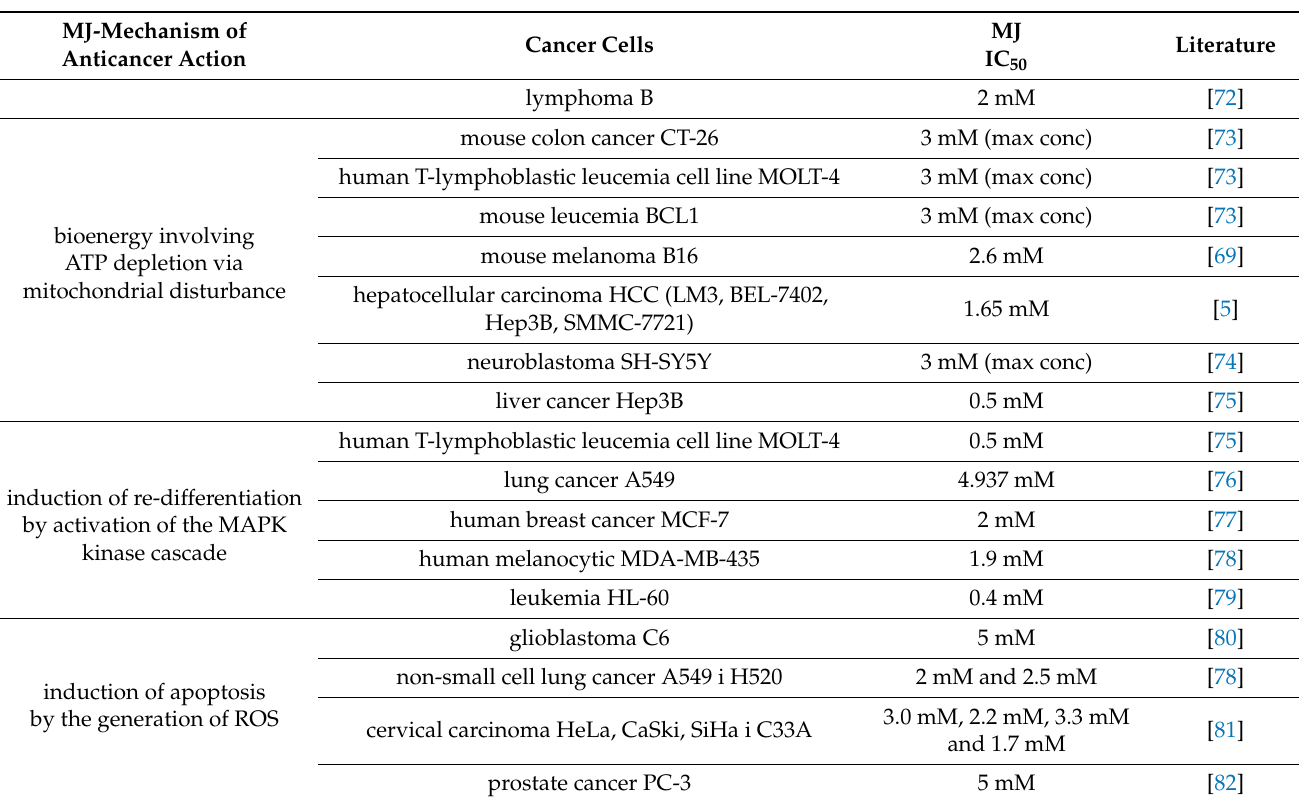
Table 3. Anticancer mechanism of MJ